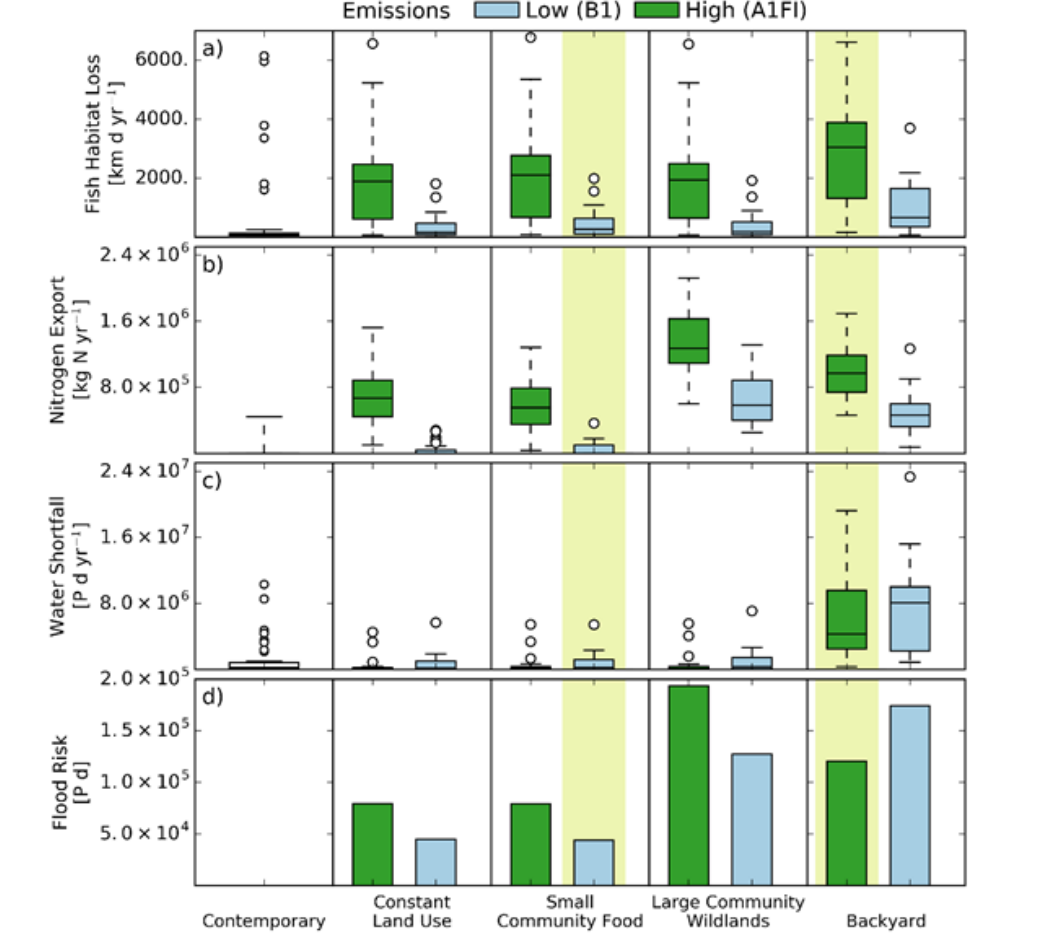
Fig. 7. Distribution of water indicators between 2075–2100 for eight scenarios (four land use and two climate; Table 1) compared with contemporary range (1980–2005), including (a) Fish Habitat Loss (km d yr -1 ), (b) Nitrogen Export (kg N yr -1 ), (c) Water Shortfalls (P d yr -1 ), and (d) total Flood Risk population-duration (P d). Boxes in panels (a)–(c) represent first to third quartiles of data with line defining median, whiskers extend to 1.5 x IQR, outliers as circles beyond. Bars in (d) represent the cumulative total population potentially flood affected during the period. Highlighted columns depict scenarios included in workshop evaluation (Mavrommati et al. 2017) and focused on Figs.